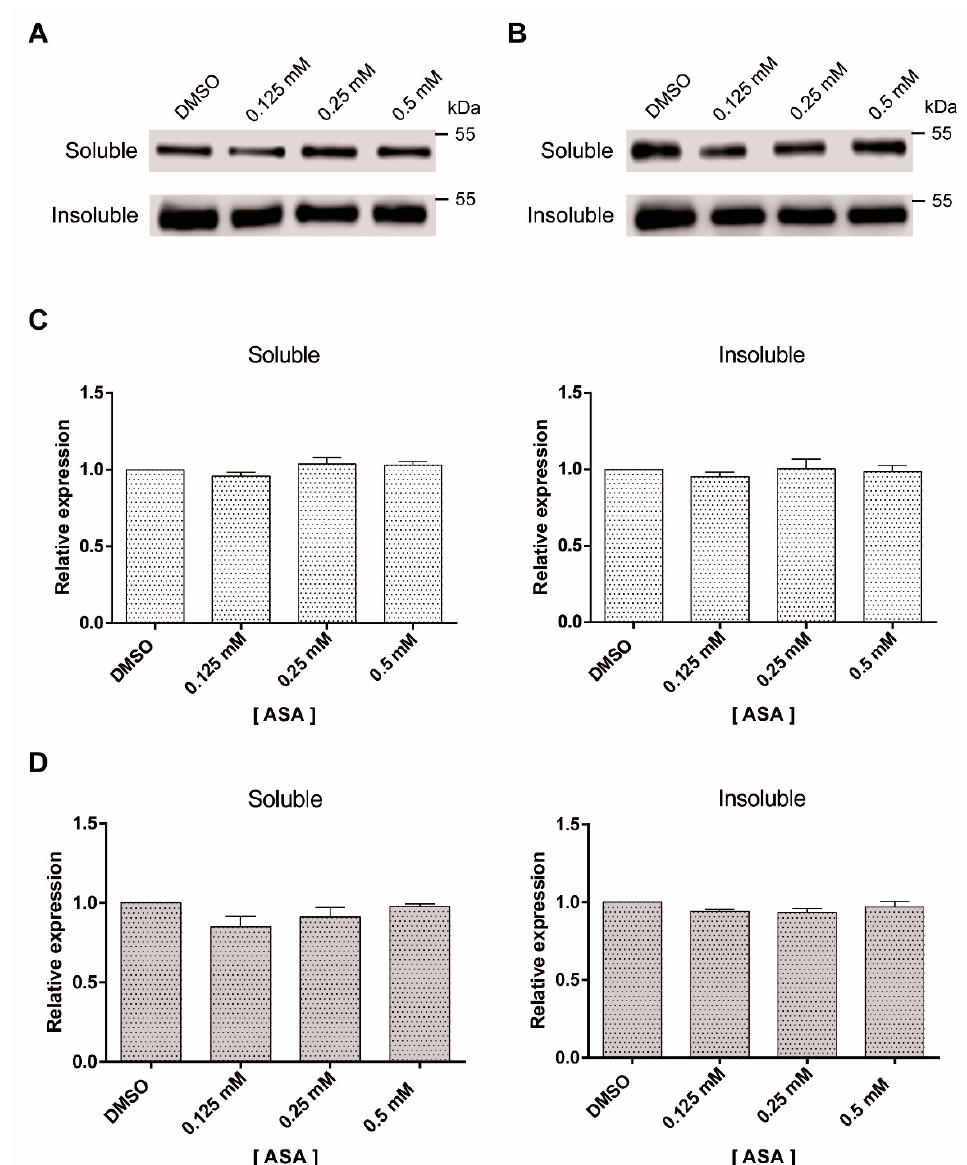
Figure 3. Soluble and insoluble tubulin fractions of Giardia trophozoites exposed to ASA. The amount of soluble and insoluble α -tubulin was analyzed by Western blotting after 24 h ( A ) and 48 h ( B ). This experiment was repeated three times. Densitometric analysis of soluble and insoluble tubulin levels after 24 h ( C ) and 48 h ( D ).